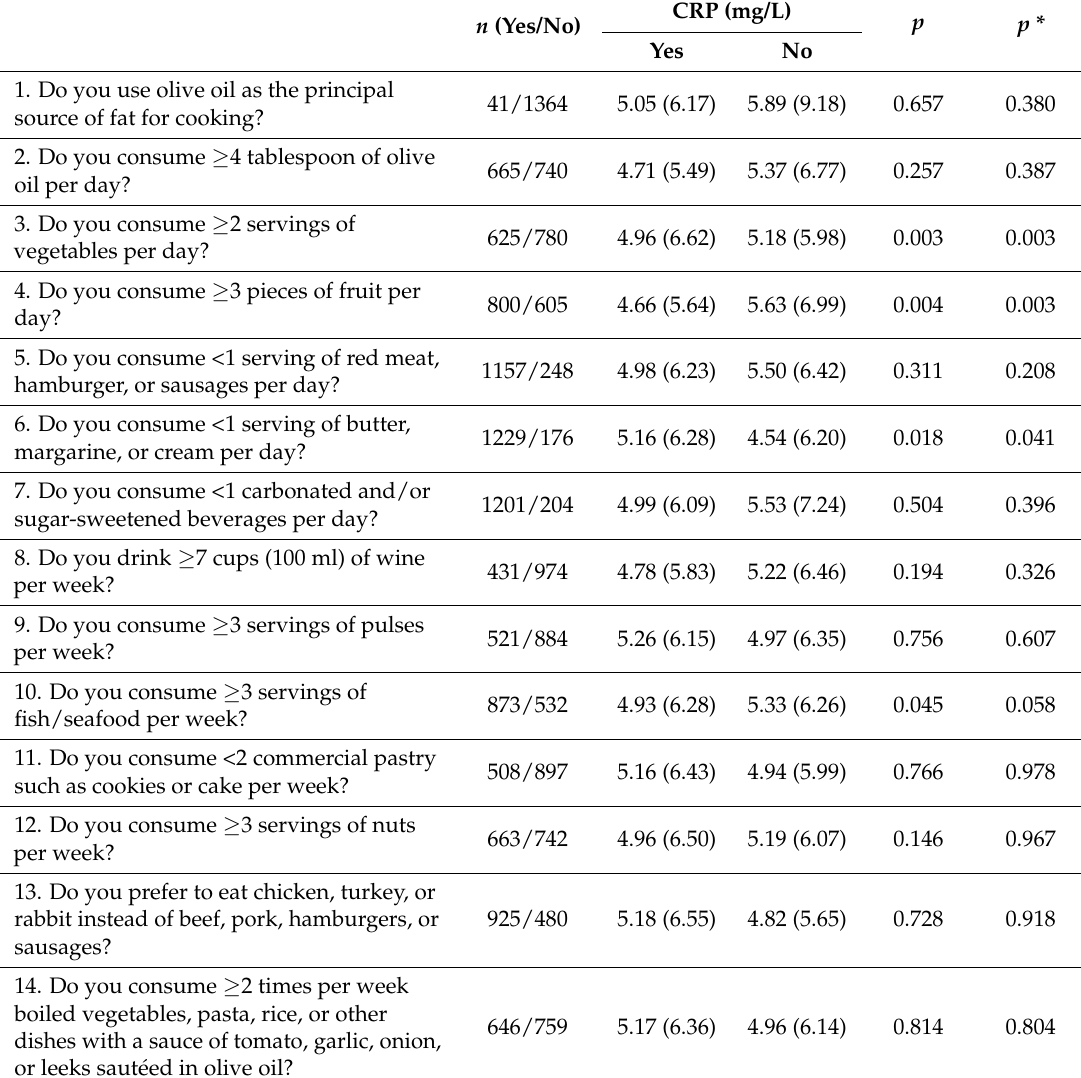
Table 3. C-reactive protein concentration depending on the answer to each point of the 14-point Mediterranean Diet Adherence Screener